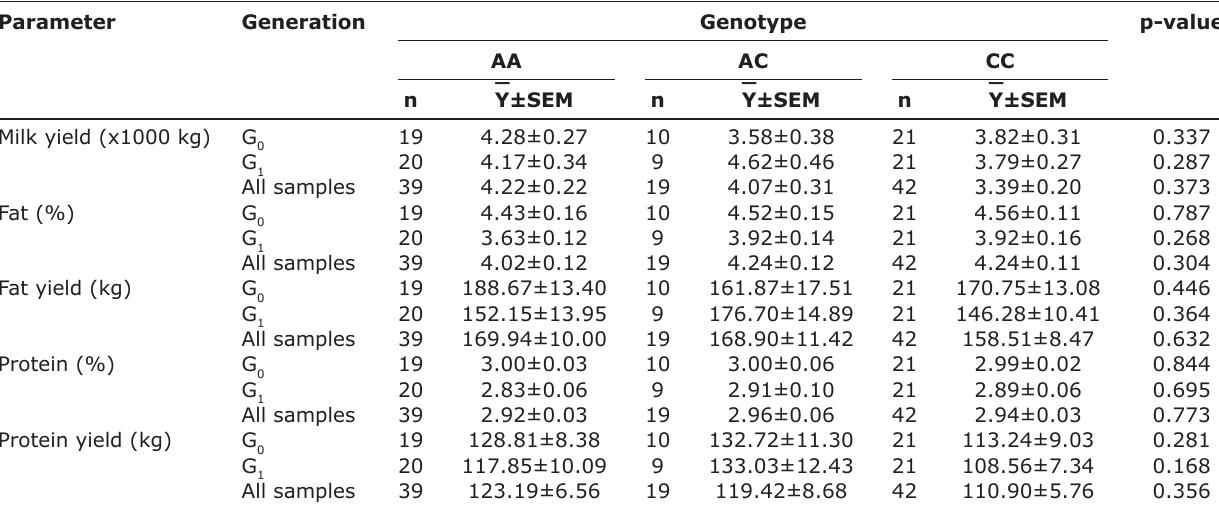
Table-4: Association of LOC514211 rs42688595 with milk traits.